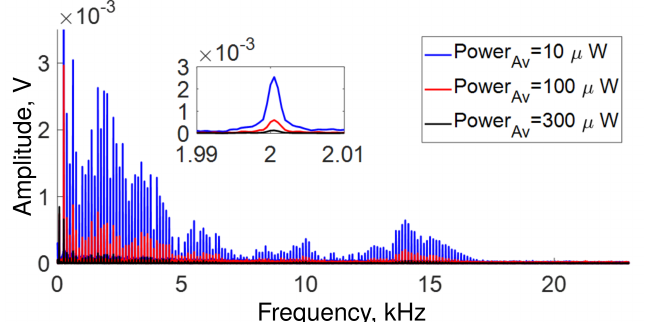
Figure 5. All frequencies detected in our setup for several average power adjusted by the angle α of QWR (see Figure 1). Inset a zoom of frequencies at 2